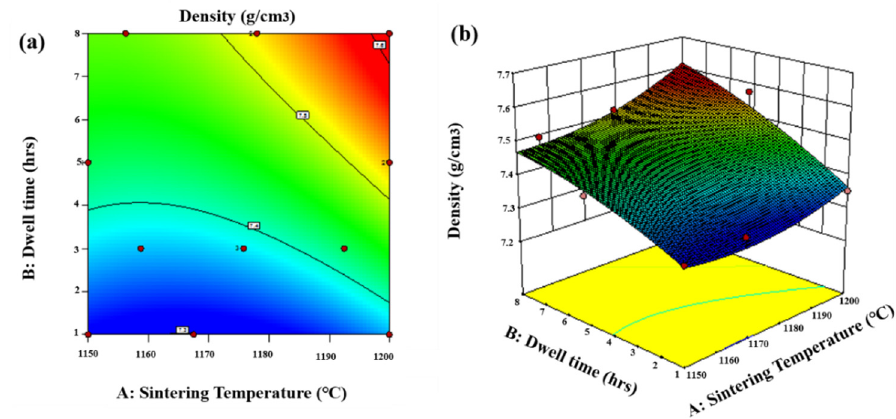
Figure 14. Contour and 3D plots of density. (a)**; (b)**.